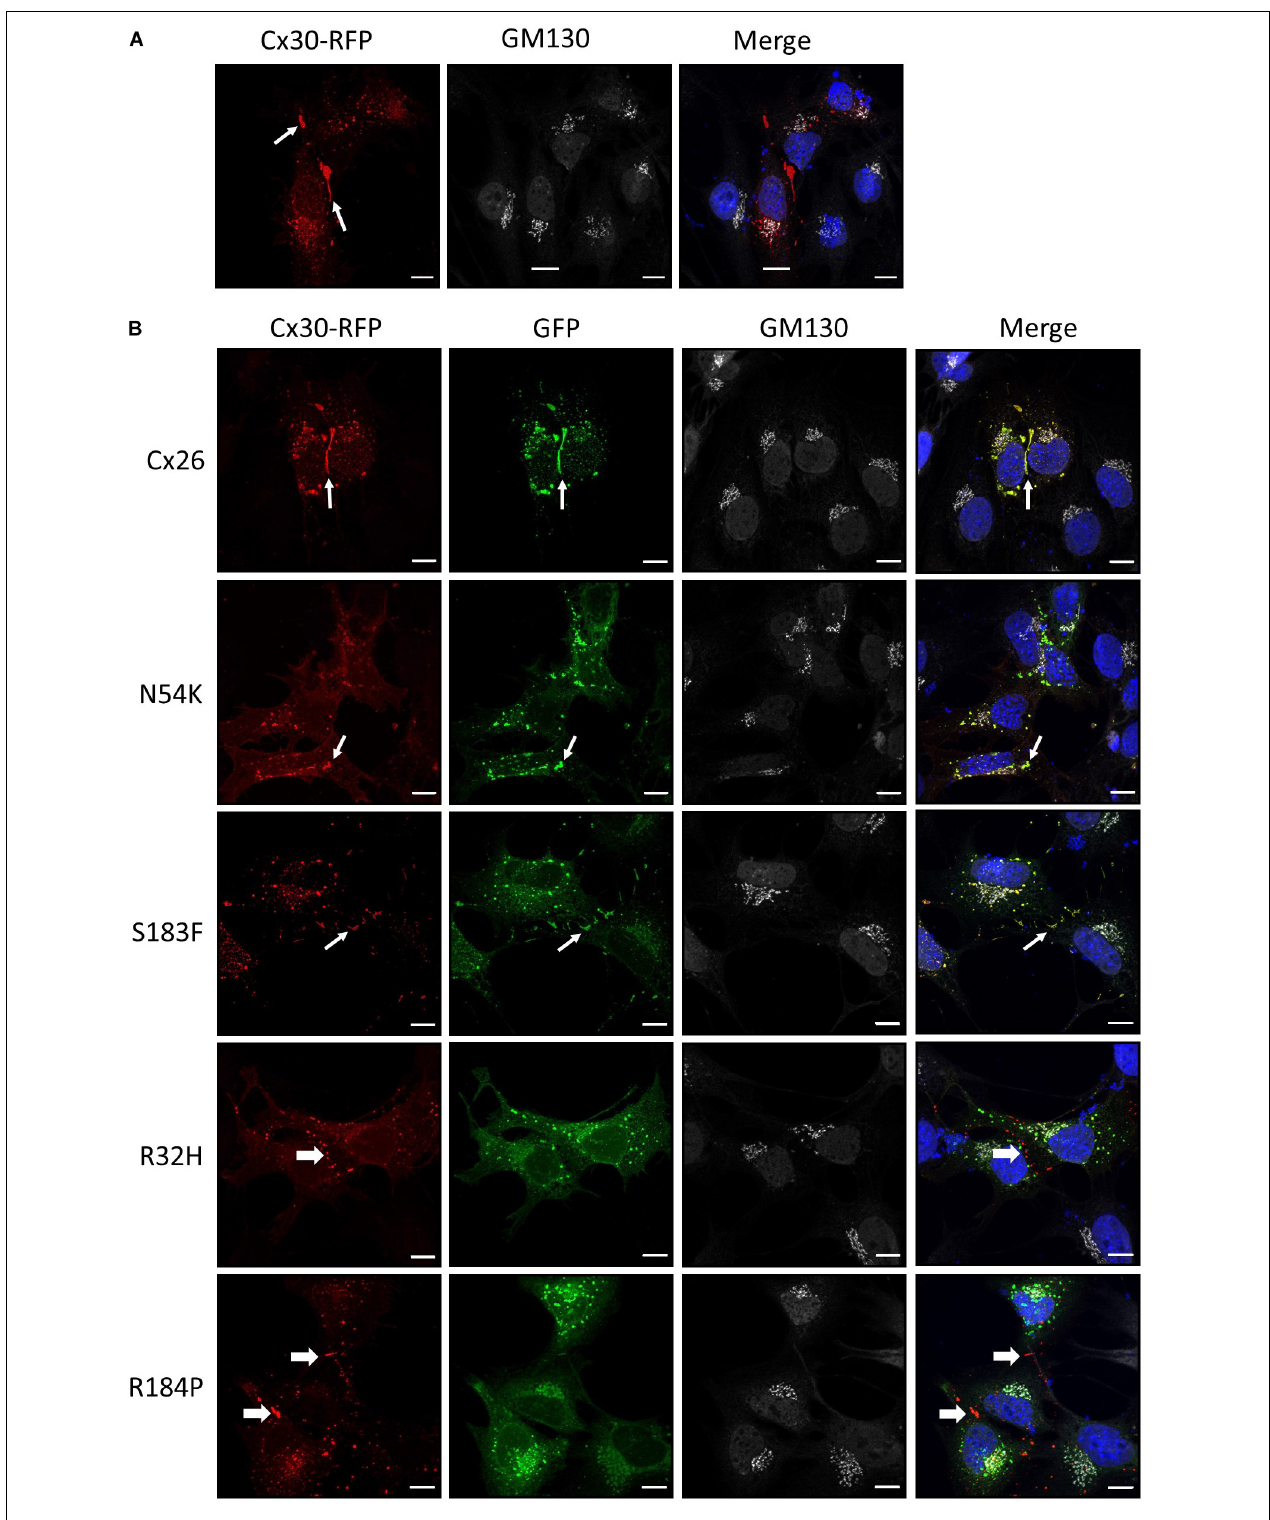
FIGURE 6 | Cx30 expression partially rescued the aberrant localization of the N54K mutant. (A) Cx30-RFP assembled into gap junctions (arrows) when expressed in Cx43 KO cells that were immunostained for GM130 (white) and counterstained with Hoechst (blue) to demarcate the nuclei. (B) Cx30 and co-expressed Cx26 or the S183F and N54K mutants localized within the same gap junction plaques, denoted by the thin white arrows. Both recessive mutants, R32H and R184P, remained intracellularly and failed to co-localize with Cx30 (thick arrows). Bars = 10 µ m.